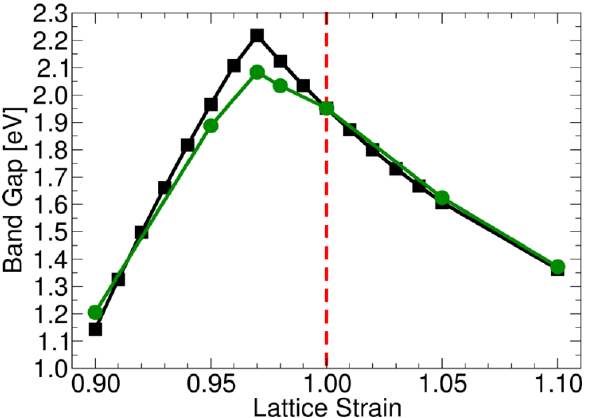
Figure 5. Summary of the influence of 2D (green circles) and 3D (black squares) strain on the band gap. Reprinted from [34] with the permission of the American Chemical Society.